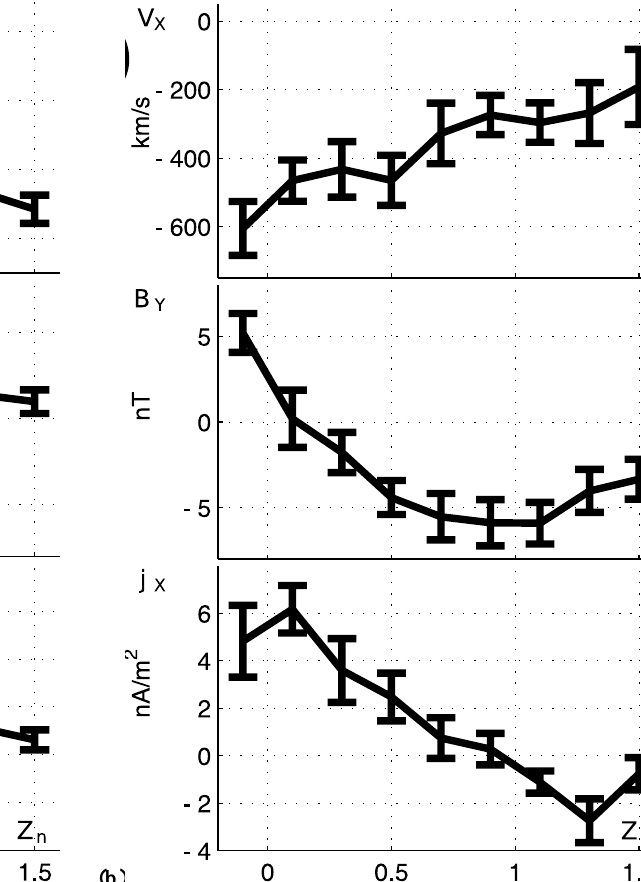
( ∼ 4000 km) is ideal for sampling different parts of the cur- rent sheet